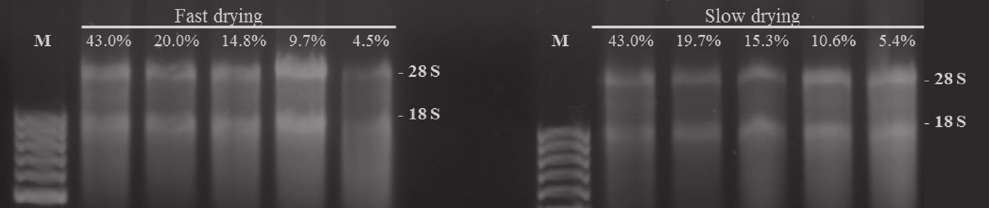
Figure 7 - Agarose gel (1%) of genomic RNA extracted of Campomanesia adamantium seeds subjected to fast drying (silica) and slow drying (room temperature) at different water contents. M: marker 100 bp (molecular weight).